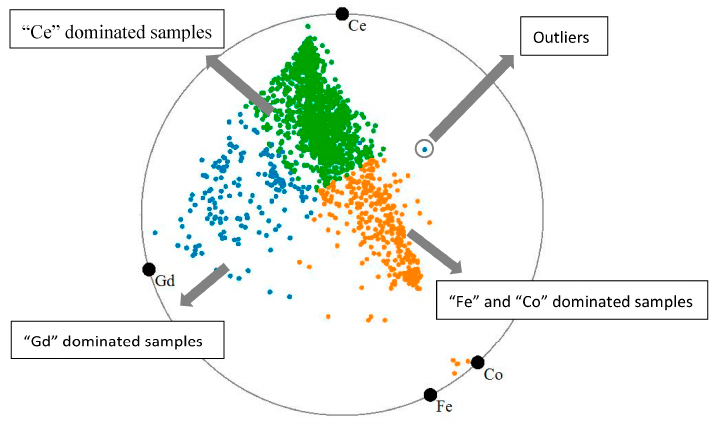
Figure 7. The battery data set visualized with RadViz Deluxe.